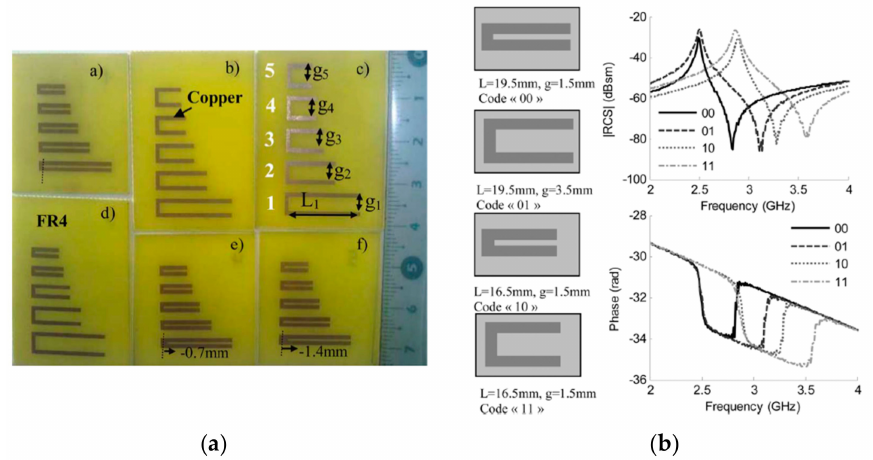
Figure 21. ( a ) Photograph of six chipless-RFID tags proposed by Vena et al. and ( b ) the measured frequency response. Figure extracted from [90].